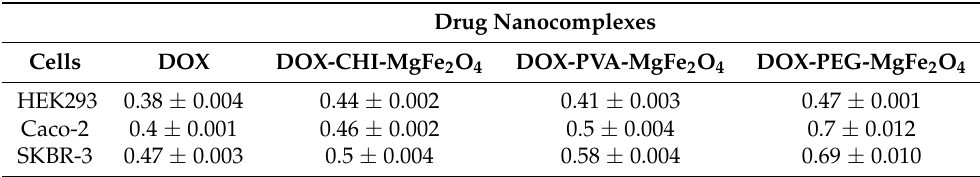
Table 7. Apoptotic Indices for DOX-loaded MNPS and free